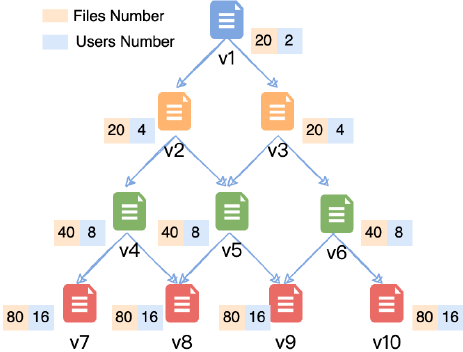
Figure 2. The Simulated Authentication Structure.